Question: What direction does the quantity move in — increasing or decreasing?
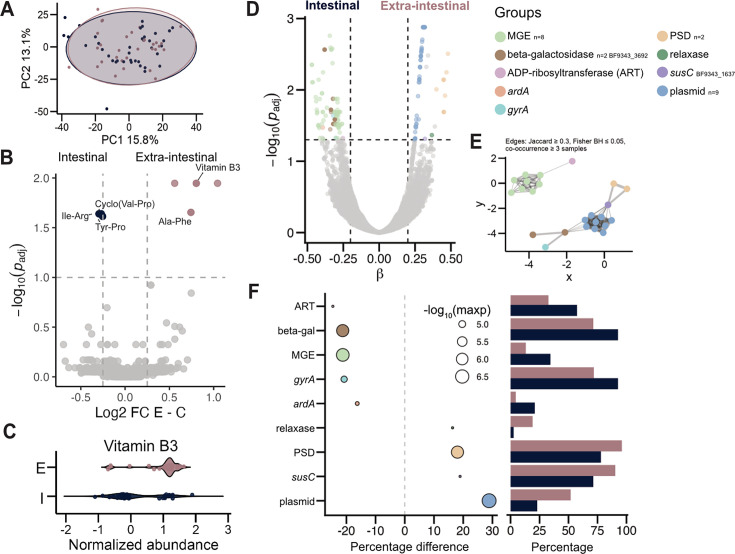
Answer: increasing